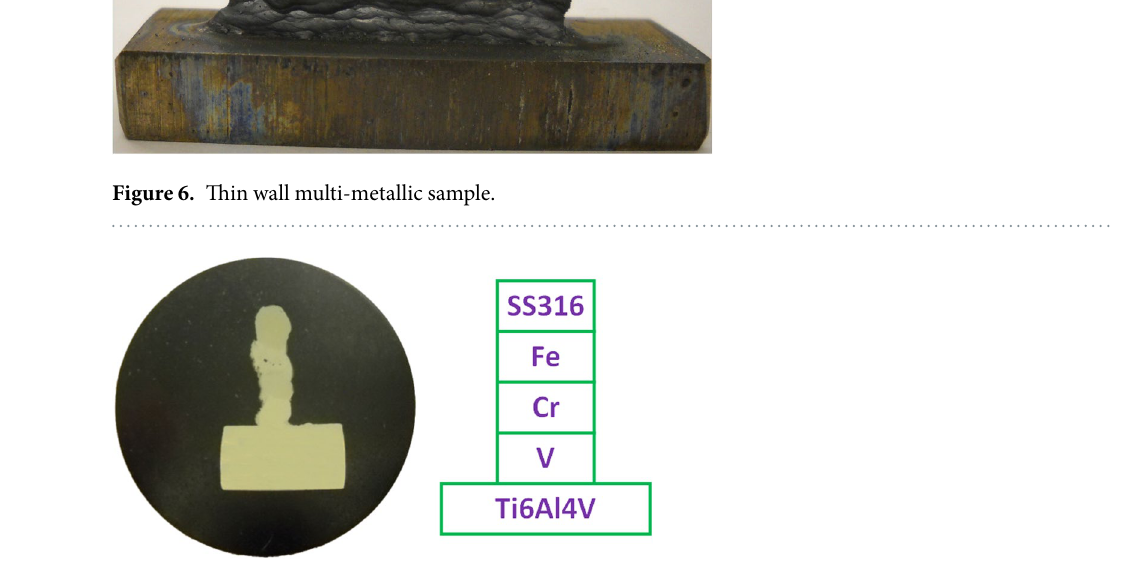
Figure 7. The specimen prepared from cross section of the printed